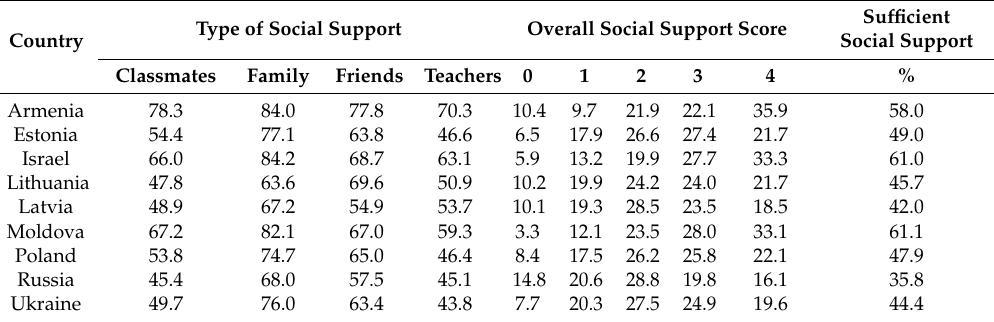
Table 5. Prevalence of high social support by country and support type, %.